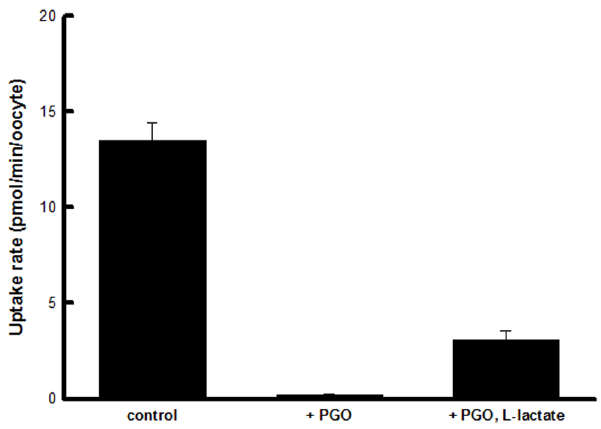
Figure 5. Effect of PGO modification on transport activity via hMCT4. Oocytes were preincubated at 25 u C for 15 min with 100 mM PGO (pH 8.0) in the absence or presence of 1 M L-lactate. After treatment with PGO, oocytes were rinsed twice with transport buffer (pH 7.4). Oocytes were incubated additionally twice for 5 min with transport buffer. The oocyte were incubated for 10 min at 25 u C with transport buffer of pH 5.5 containing 0.1 mM L-lactate. Data are presented as means 6 S.E. of three independent experiments. The background uptake values of water-injected oocytes were subtracted.